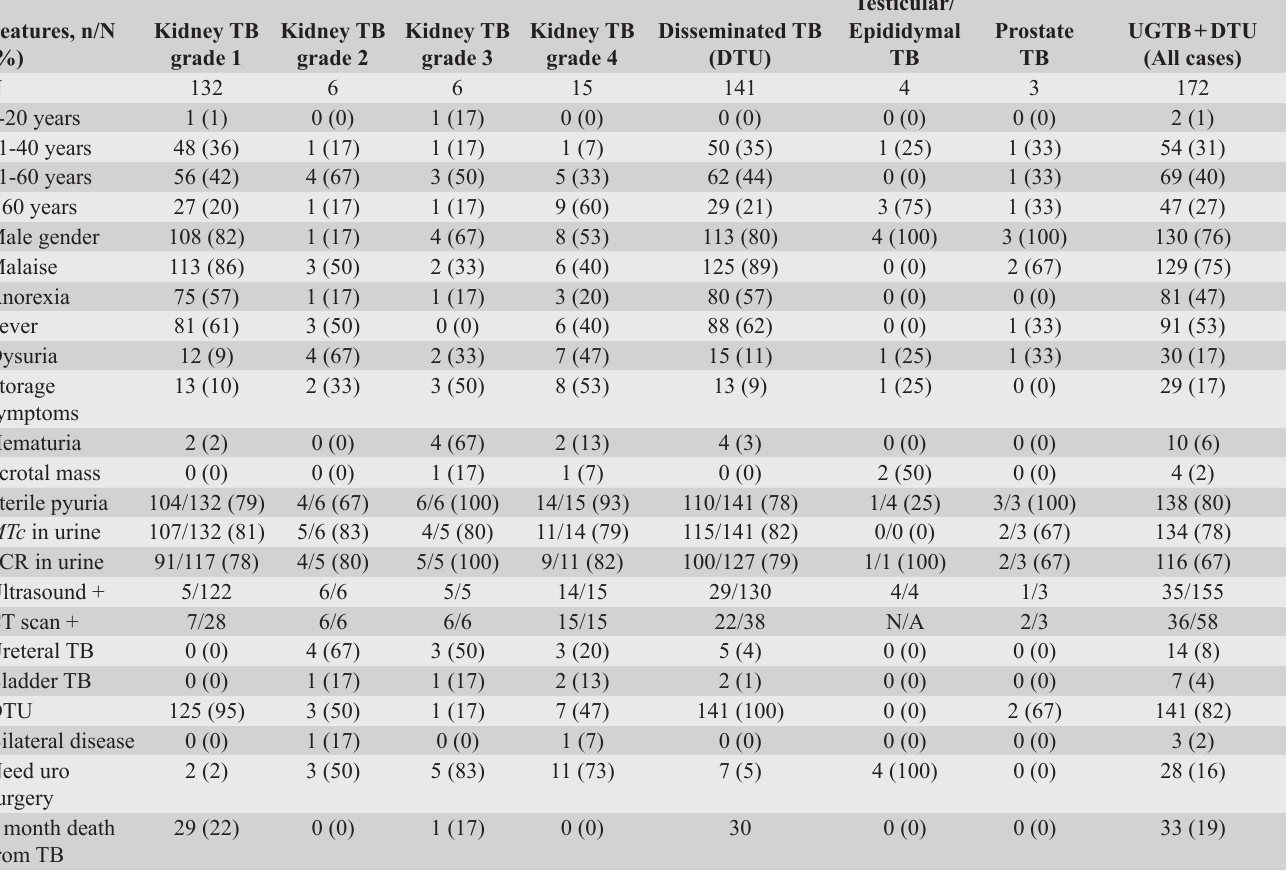
Supplementary Table 1. Patient Data Based on Affected